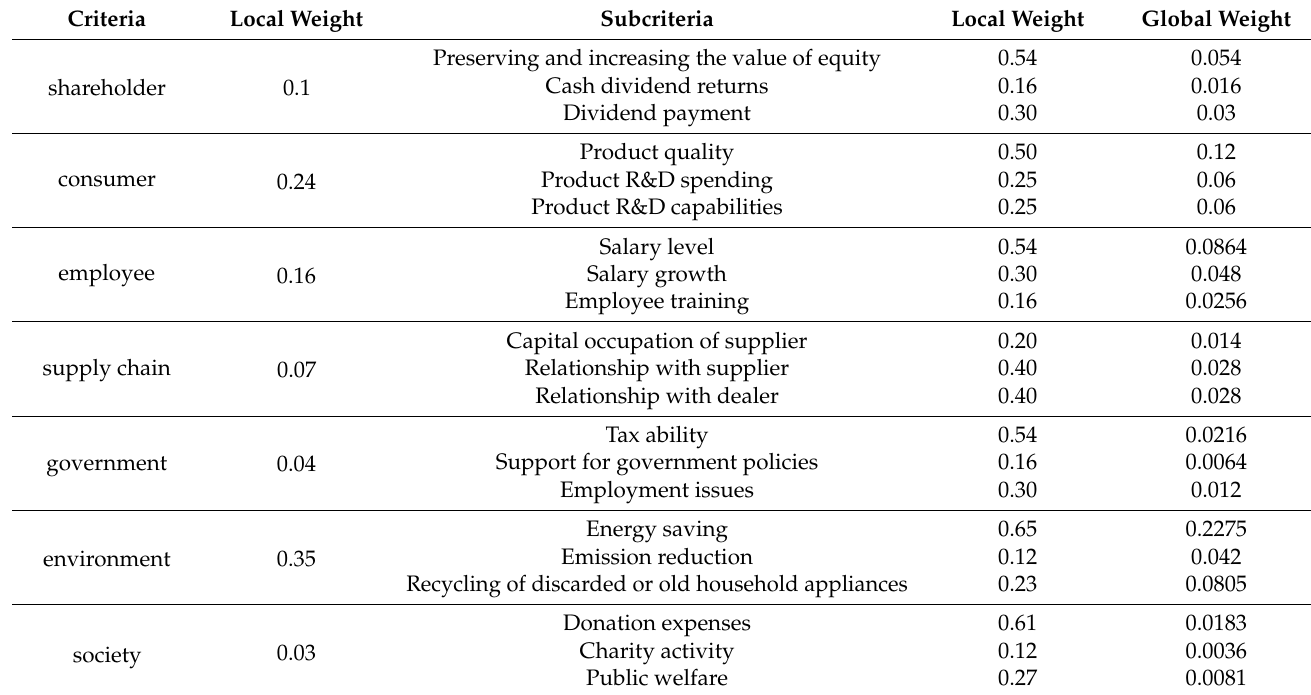
Table 3. Summary of weights of criteria and